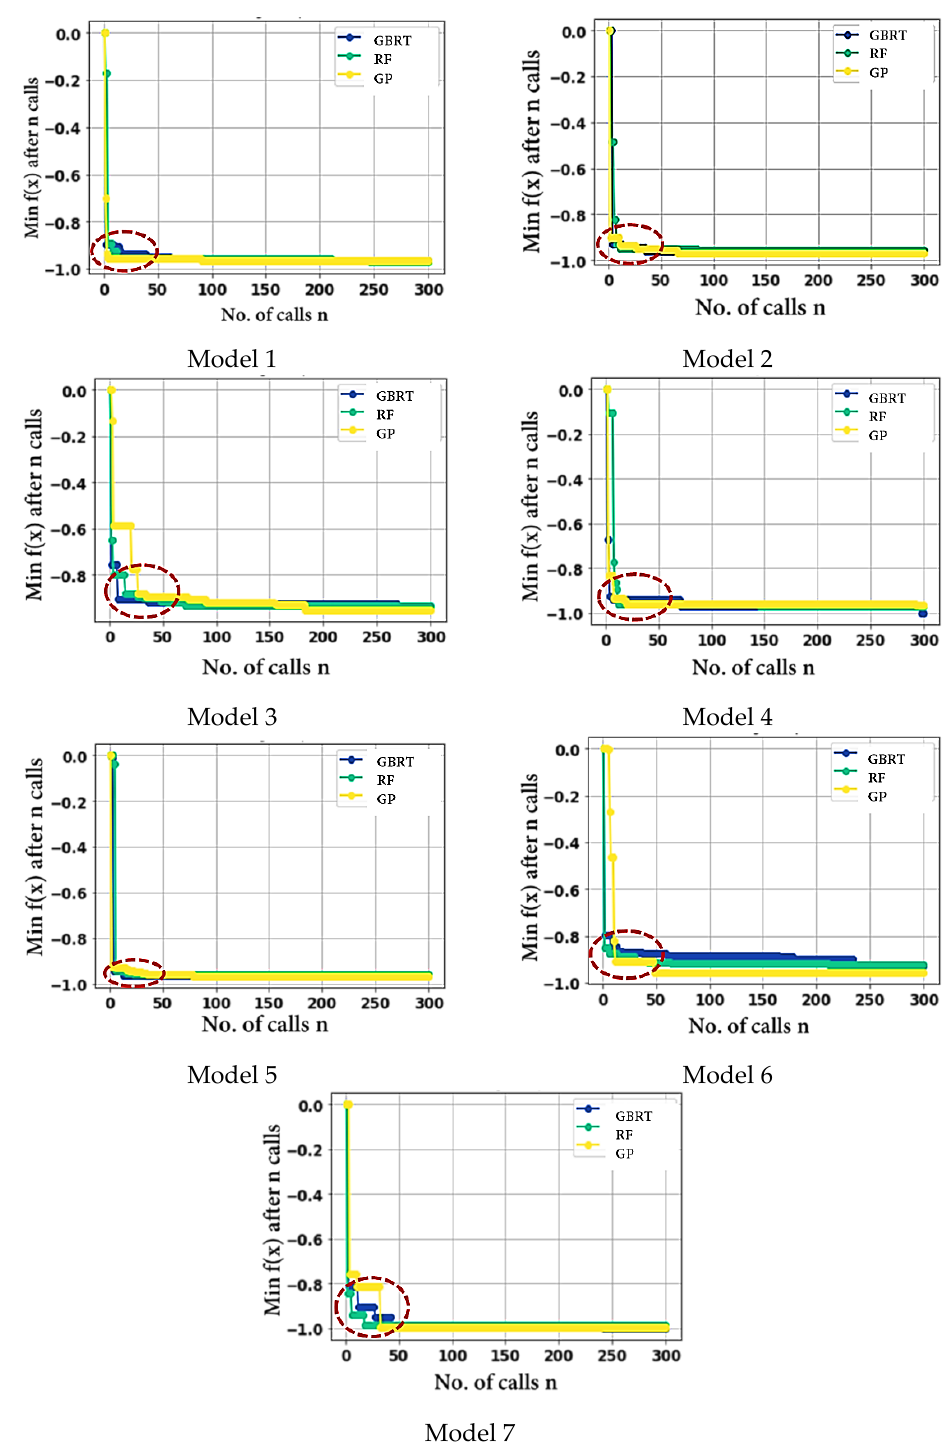
Figure 10. Convergence of the developed models